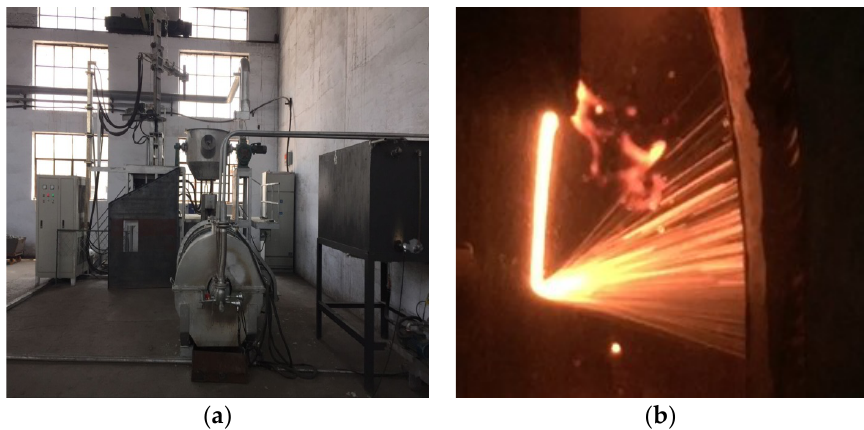
Figure 1. Experimental diagram of gas quenching BFS: ( a ) Experimental equipment diagram; ( b ) Gas quenching diagram.